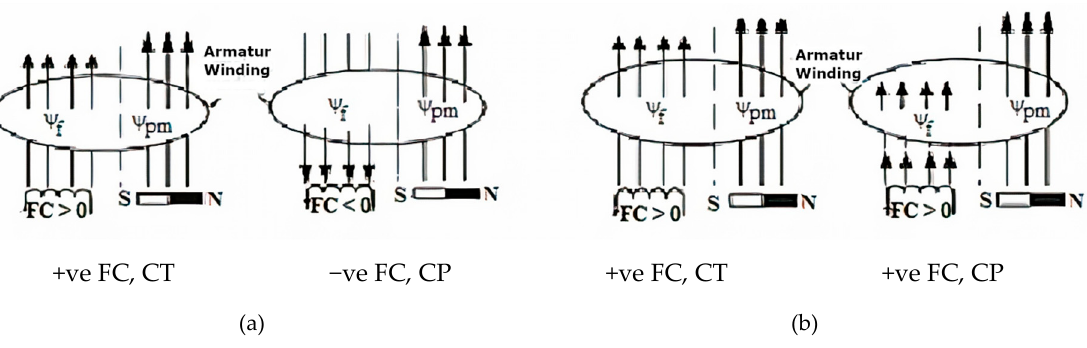
Figure 5. ( a ) Flux-weakening control using +ve and –ve field current (FC); ( b ) proposed flux-weakening control using +ve FC.